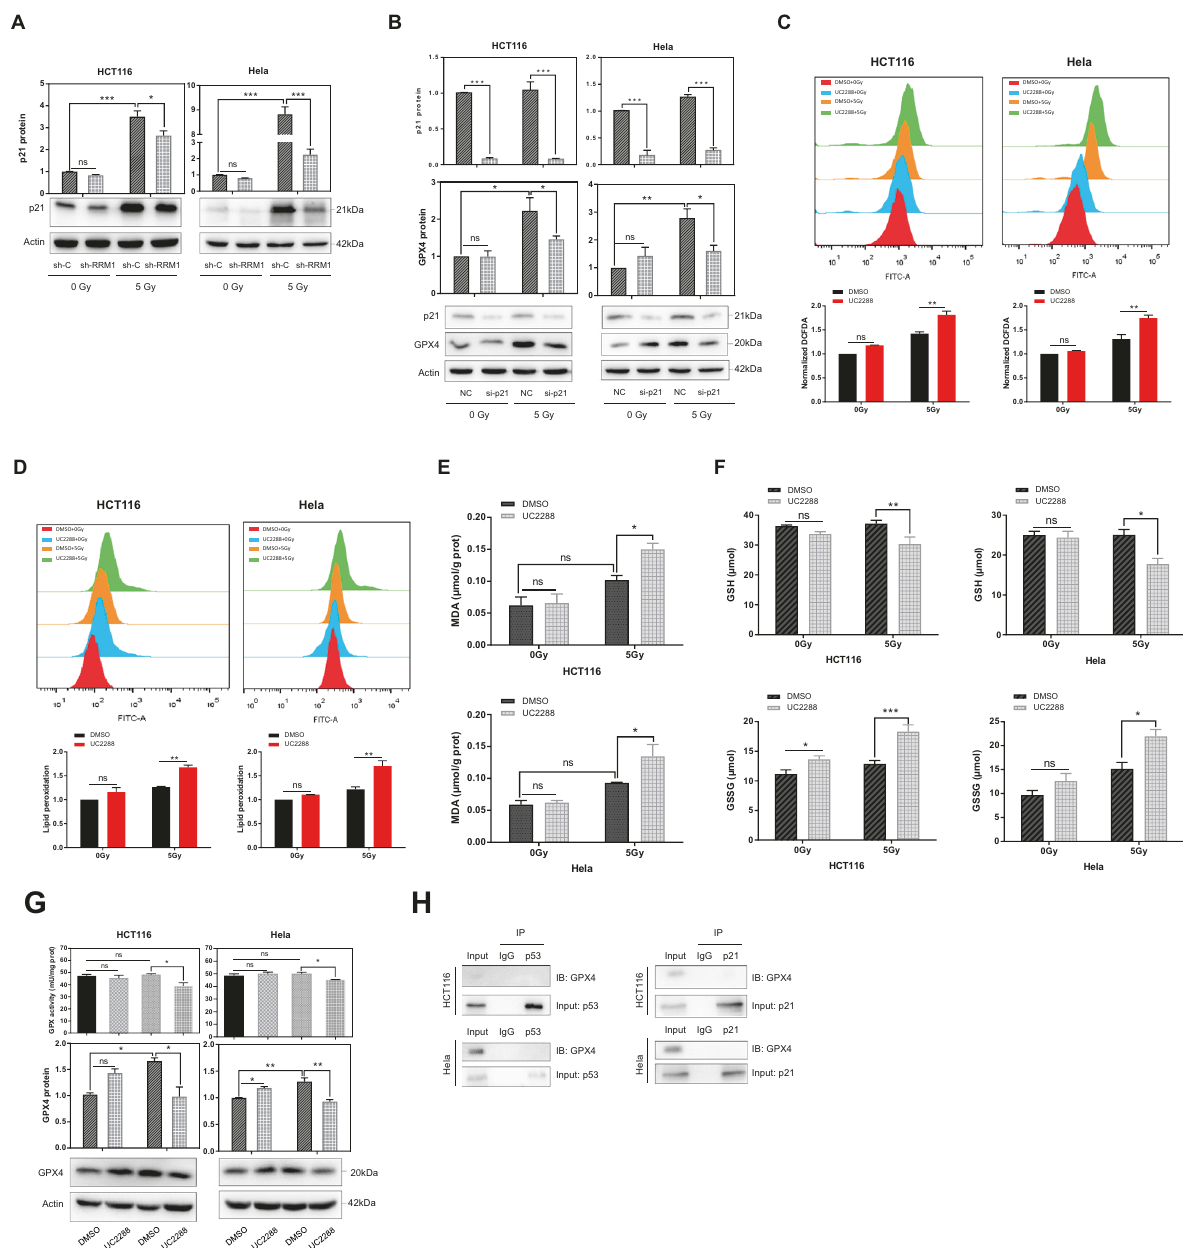
Fig. 4 RRM1 regulates GPX4 by inhibiting the p53-p21 signal axis. A p21 protein was detected in RRM1 knockdown cells after exposure to 5 Gy γ -ray. B Low expression of GPX4 protein was analyzed in p21 knockdown cells after 5 Gy γ -ray. C – F Total ROS levels ( C ), lipid peroxidation ( D ), MDA ( E ), and GSH and GSSG levels ( F ) were detected in HCT116 and Hela cells at 24 h after exposure to 1 µM UC2288 and 5 Gy γ -ray. G Lower GPX activity and GPX4 expression were detected in control and 5 µM UC2288 treated cells upon 5 Gy γ -ray. H The interaction of endogenous GPX4 with p53 or p21 was examined by Co-IP